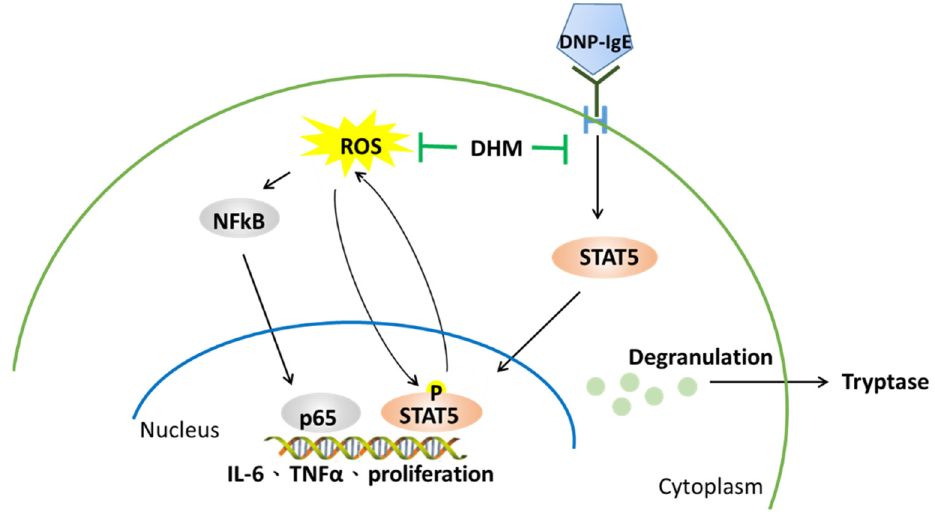
Figure 6. Proposed mechanism by which DHM diminishes IgE-stimulated cell proliferation, cytokine production, and degranulation in KU812 cells.